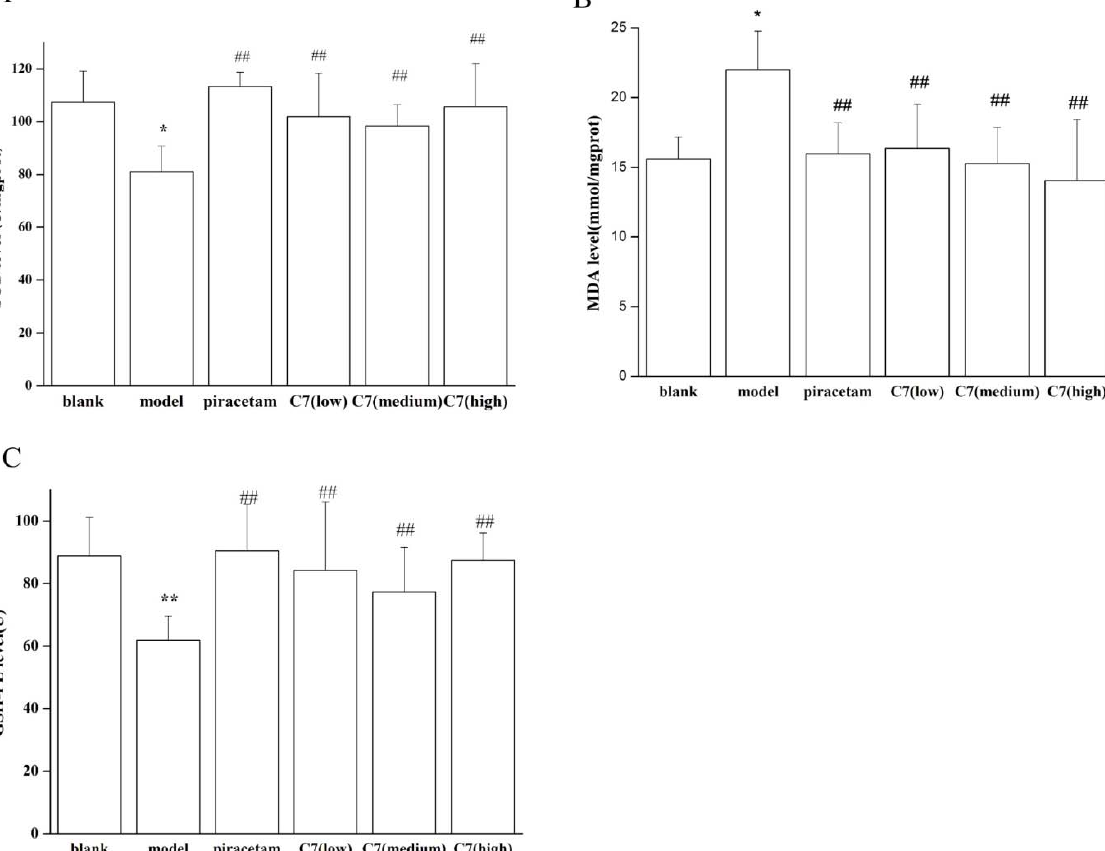
*, p < 0.05 vs. blank group, **, p < 0.01 vs. blank group; ##, p < 0.01 vs. model